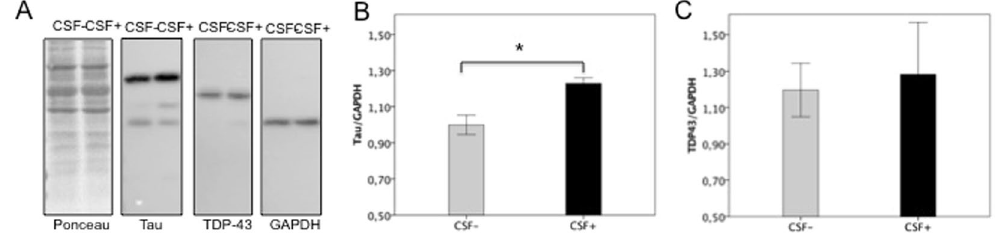
Figure 6. Effect of GluA3 antibodies in neurons differentiated from human iPSc on Tau and TDP43 expression. ( A ) Representative WB analysis from homogenates of neurons differentiated from human iPSc and incubated for 24 hours with CSF with (CSF + ) or without (CSF − ) anti-GluA3 antibodies (dilution 1:100). ( B , C ) The histogram shows the quantification of the expression levels of Tau ( B ) and TDP43 ( C ), normalized on GAPDH; results are expressed as mean ± standard errors (SEM), * p < 0.05, paired Student’s